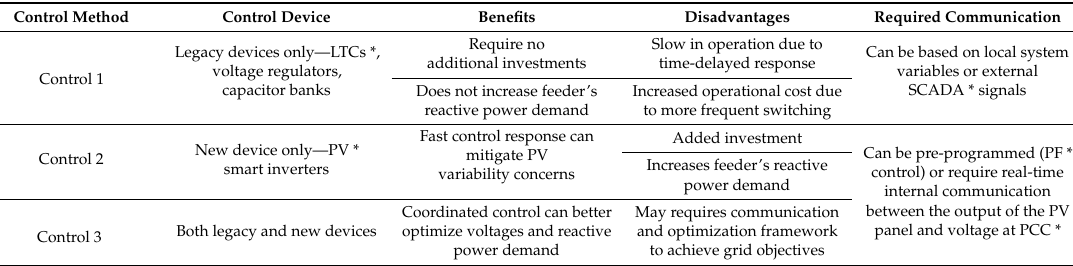
Table 1. Voltage control